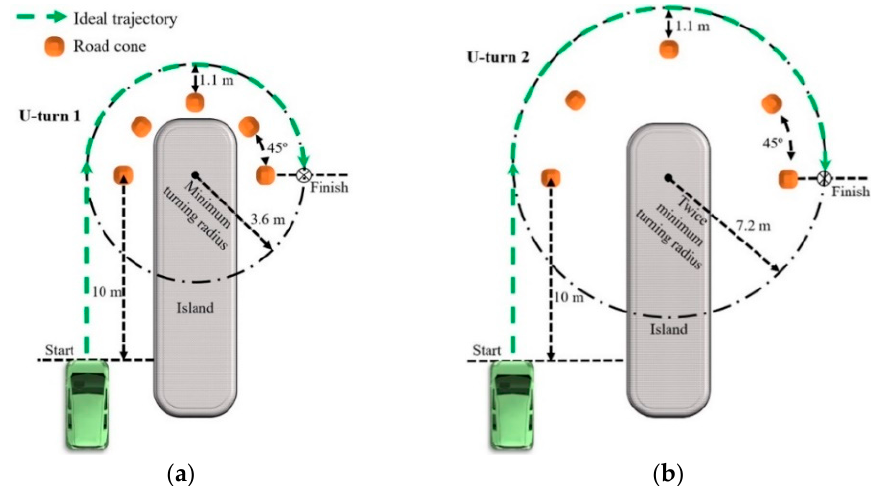
Figure 8. Driving simulator scenarios consisting of U-turns with radii of curvature equal to ( a ) 3.6 m and ( b ) 7.2 m. Note: figures not to scale.